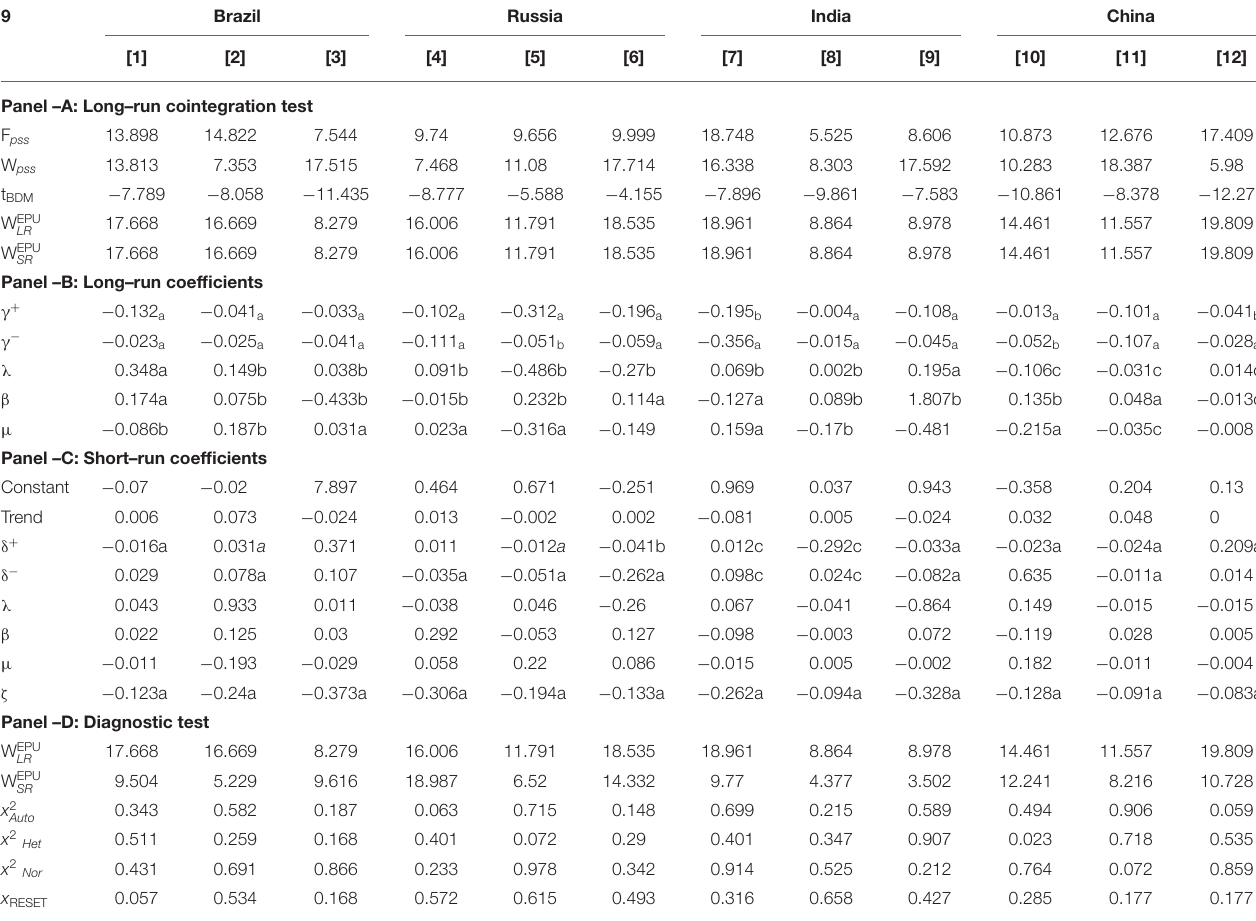
TABLE 5 | Results of asymmetric model